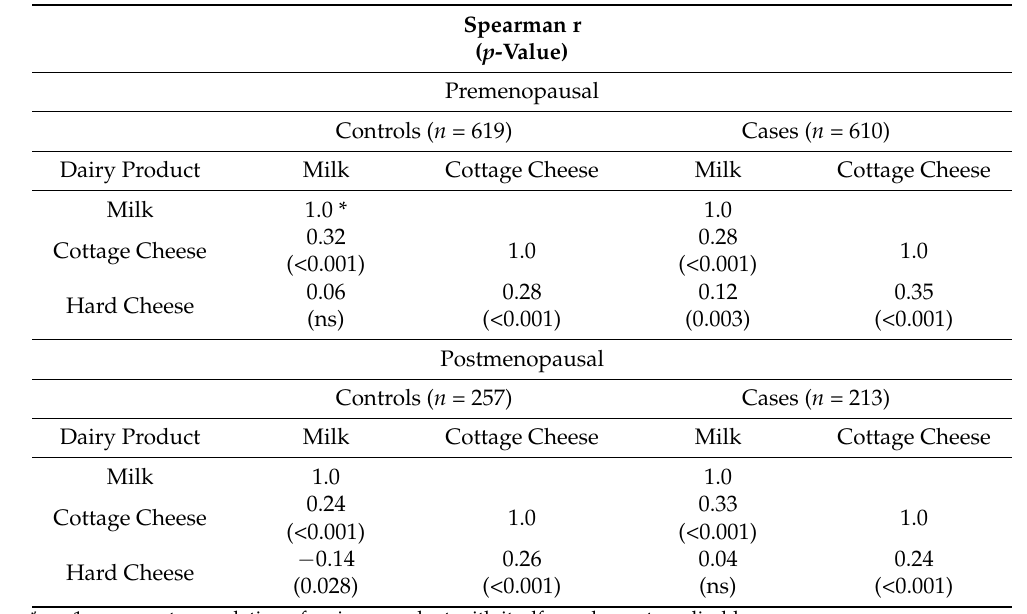
Table 3. Dairy products correlations (Spearman r) and corresponding p -values among Polish women residing in Gliwice, Katowice, Pozna´n and Białystok.